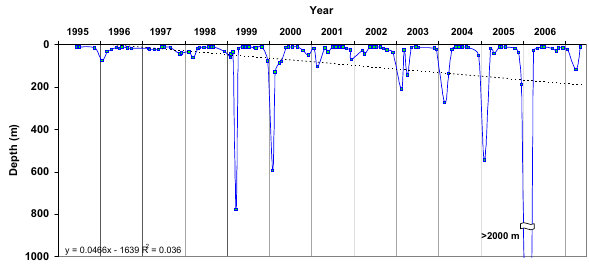
Fig. 7. Mixed layer depth variation and regression line during 1995– 2007 survey at the DYFAMED site, North Western Mediterranean